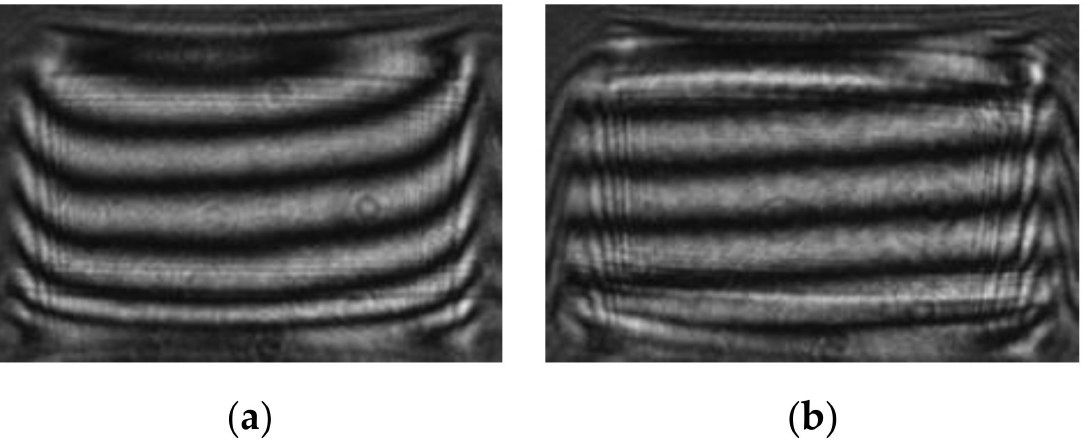
Figure 16. The interference fringes ( a ) before and ( b ) after phase